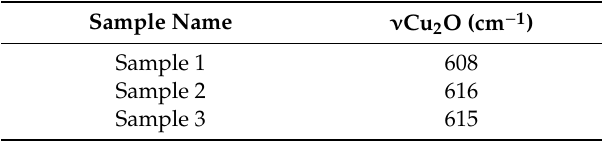
Table 4. Transmission peaks for Cu 2 O:N thin